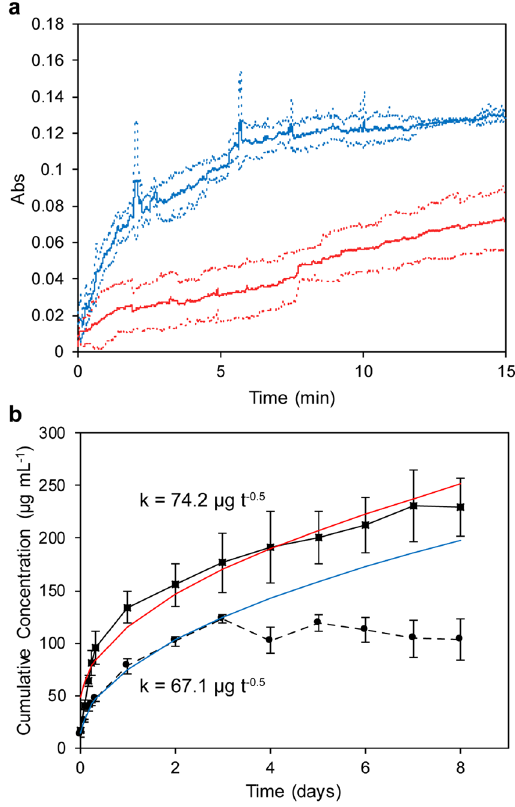
Figure 4. OCT-MSNs release drug more slowly and more predictably than OCT-loaded MCM-41. ( a ) Absorbance of OCT at 281 nm, measured by fibre optic probe, released from either control OCT-loaded MCM-41 (blue) or OCT-MSNs (red). ( b ) Cumulative release from OCT-MSNs ( ▪ , &#x25AC;) compared to OCT-loaded MCM-41 ( ● , ▪▪▪ ). Higuchi model kinetic parameters k are displayed alongside fitted modeled release from OCT-MSNs (red) and OCT-loaded MCM-41 (blue). Error dotted lines ( a ) or bars ( b ) represent ± 1 standard deviation, N =